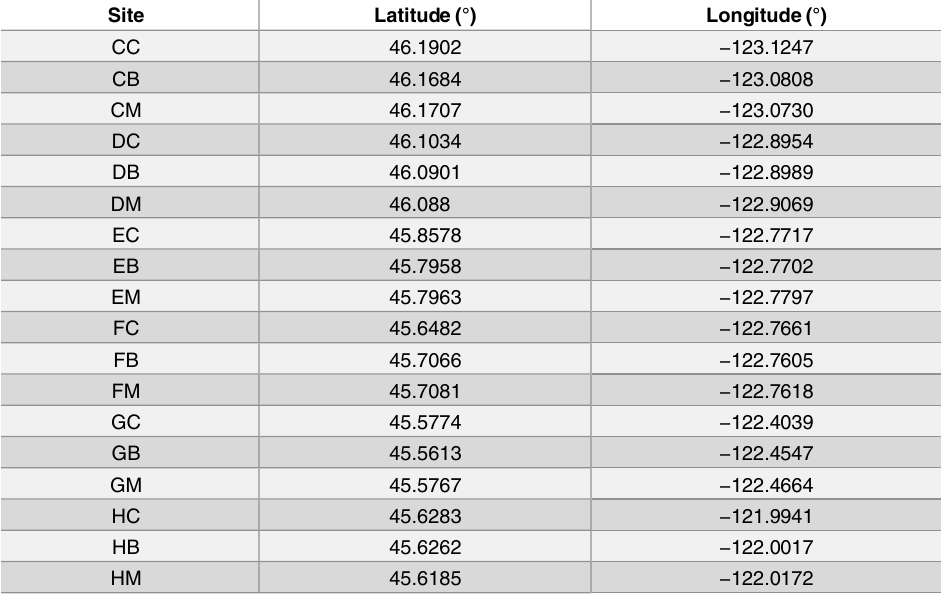
Table 1. A list of geographic coordinatesfor the study sites(adapted from Teel et al.